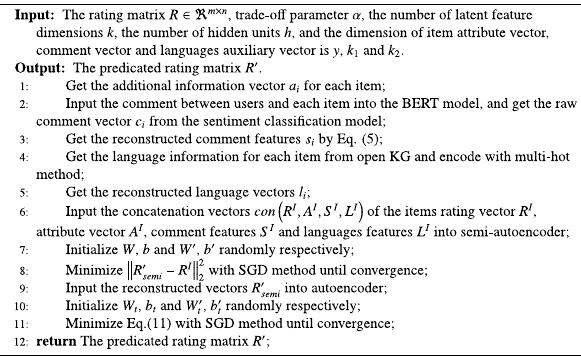
Algorithm 1. Recommendation with knowledge graph via